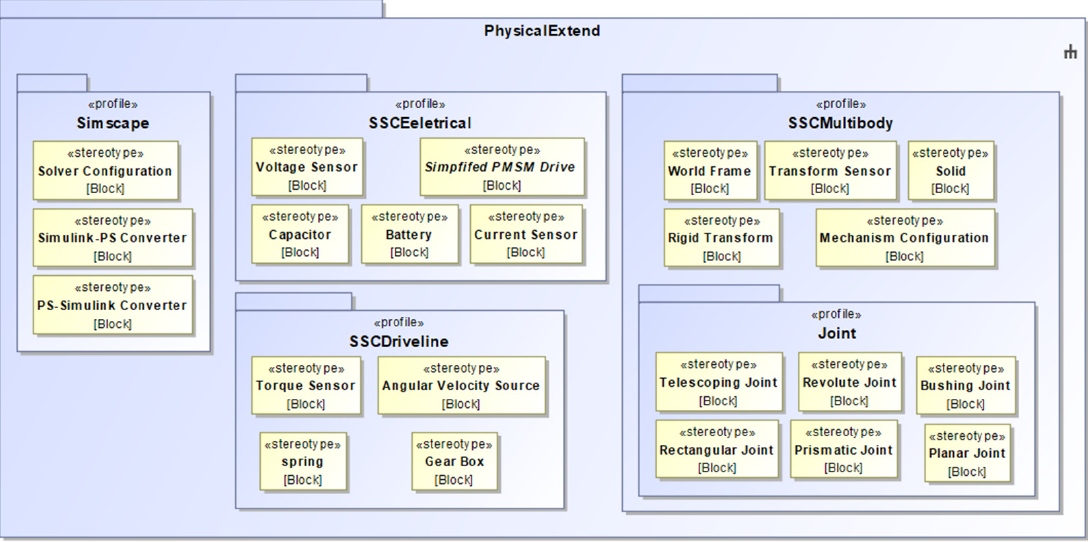
Figure 4. SysML physical extension profile.